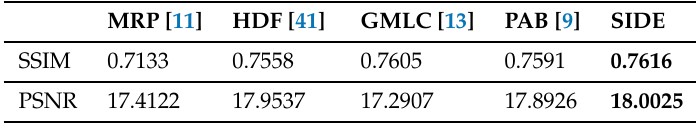
Table 2. Quantitative comparison on the synthetic test image. The bold indicates the best scores of the quantitative